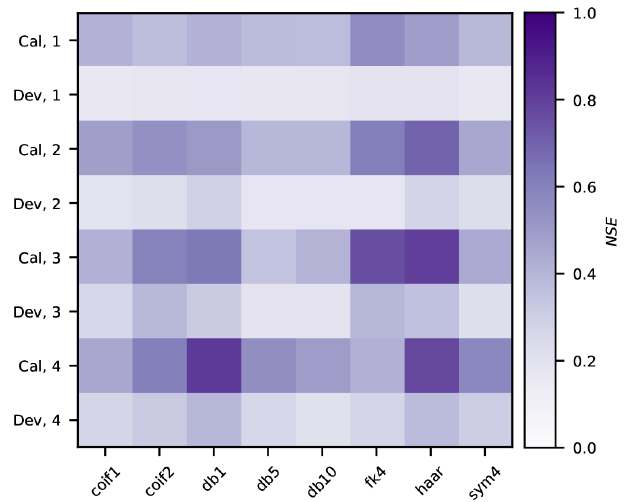
Figure 12. NSE of the BCMODWT-SVR scheme for different wavelet types and decomposition levels. The horizontal axis repre- sents the wavelet types, while the two vertical axes respectively rep- resent the decomposition level and the modeling stage (e.g., “Cal, 1” and “Dev, 1” respectively represent the calibration and develop- ment stages with a decomposition level of